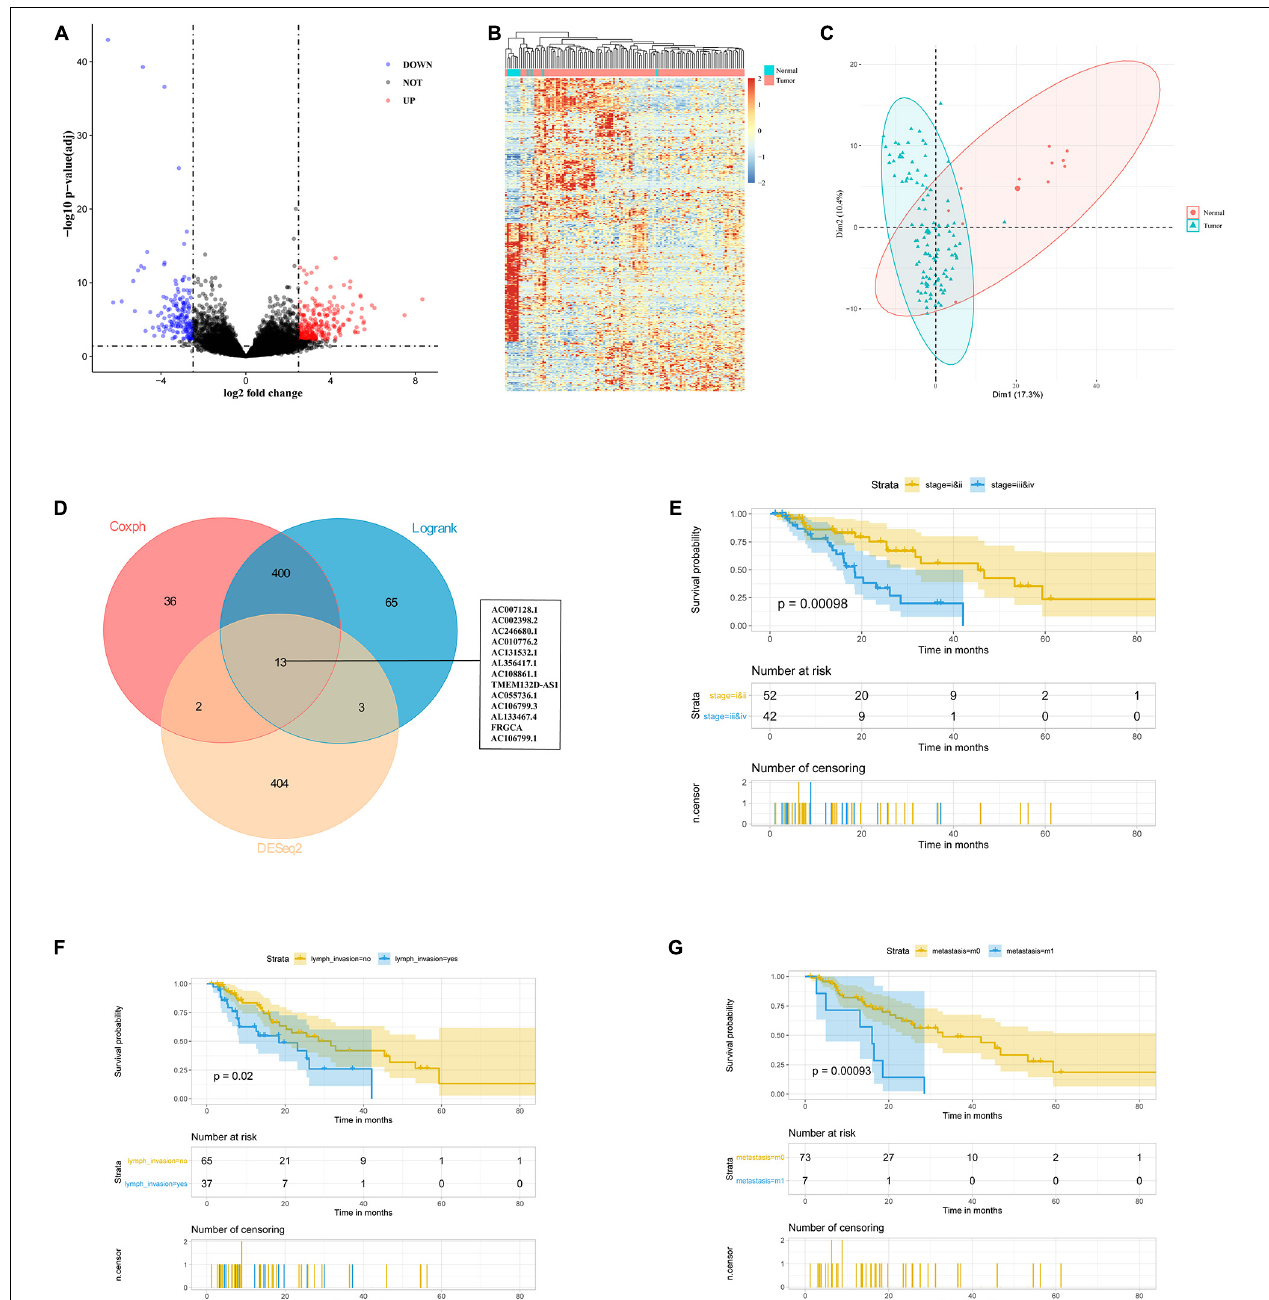
FIGURE 1 | Identification of 13 lncRNAs as candidate prognostic markers for ESCC. (A) Volcano plot exhibited differentially expressed lncRNAs. (B) Heatmap analysis showed that ESCC patients could be distinguished by dysregulated lncRNAs. (C) PCA showed successful segregation between tumor and normal tissues. (D) The intersection of differentially expressed and prognostic lncRNAs by DEseq2, log-rank, and cox analysis. (E–G) Exploratory KM analysis (log-rank test) of the OS probability (with 95% confidence intervals) in ESCC patients [ (E) TNM stage; (F) lymph node metastasis; and (G) distant metastasis].